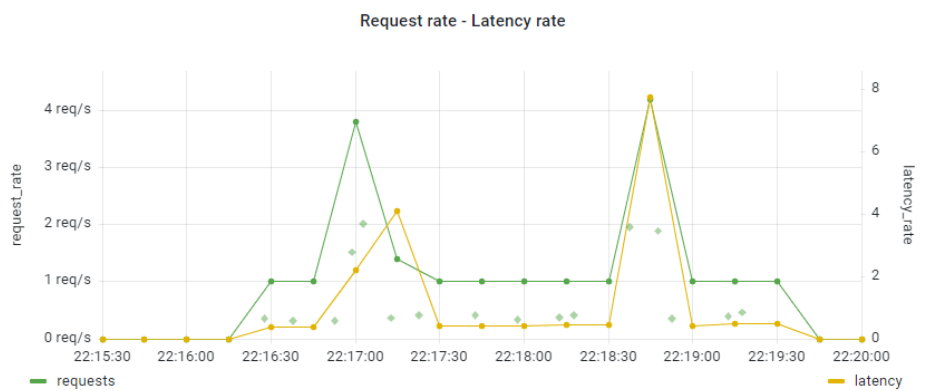
Figure 10. Request rate and latencies variation under the smooth workload.